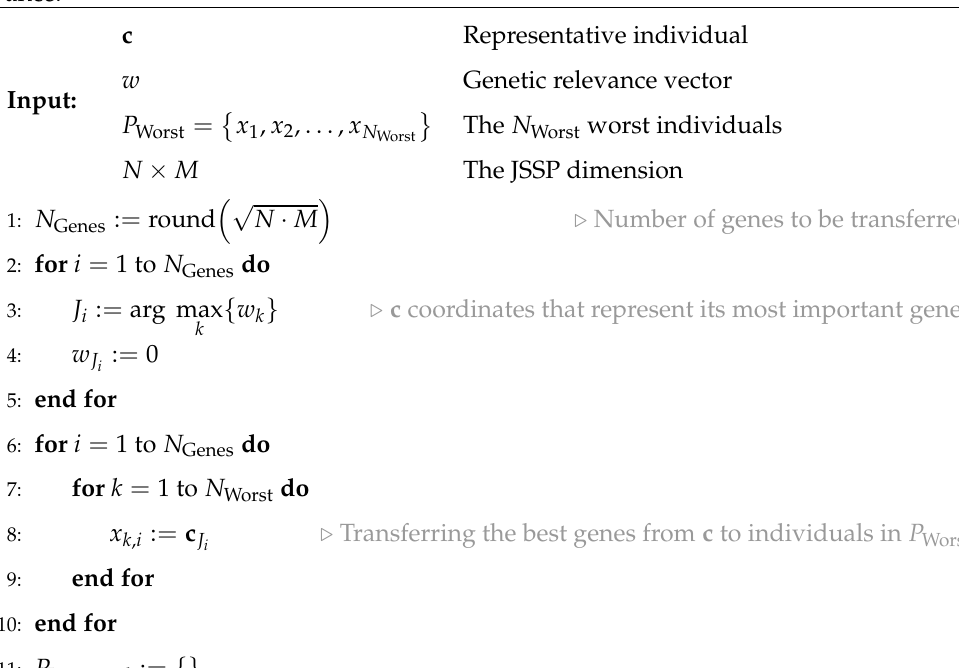
Algorithm 4 Population improvement using representative individual and genetic rele- vance.